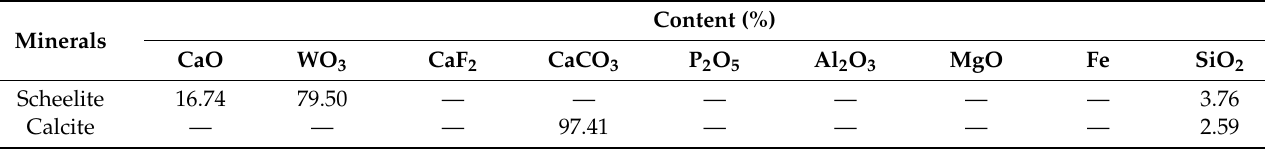
Figure 2. X-ray diffractometry patterns of ( a ) scheelite and ( b ) calcite samples. Table 1. Chemical content of the scheelite and calcite samples.